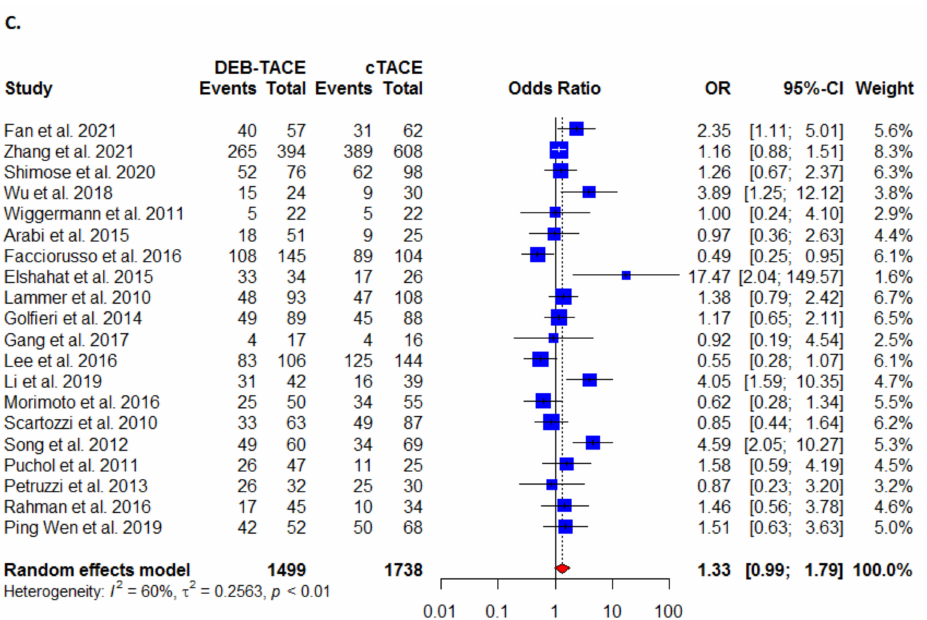
Figure 2. Forest plots for ( A ) complete response analysis; ( B ) partial response analysis; ( C ) objective response analysis between DEB-TACE (experimental) and c-TACE (control) treatment in patients with hepatocellular